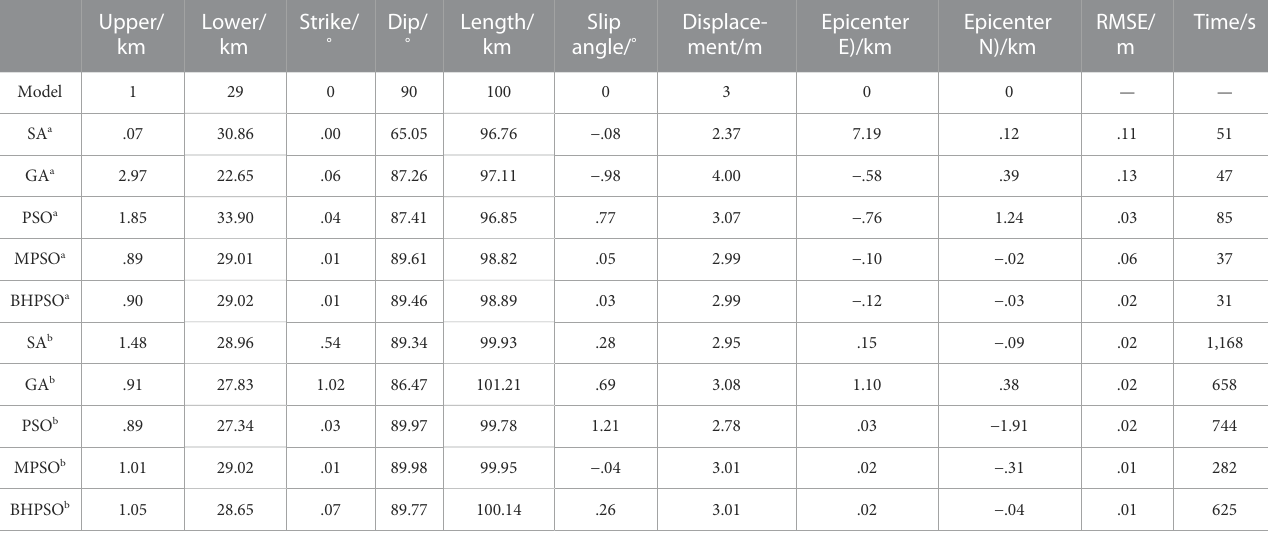
a Represent the GPS, data. b Represent the InSAR, data.